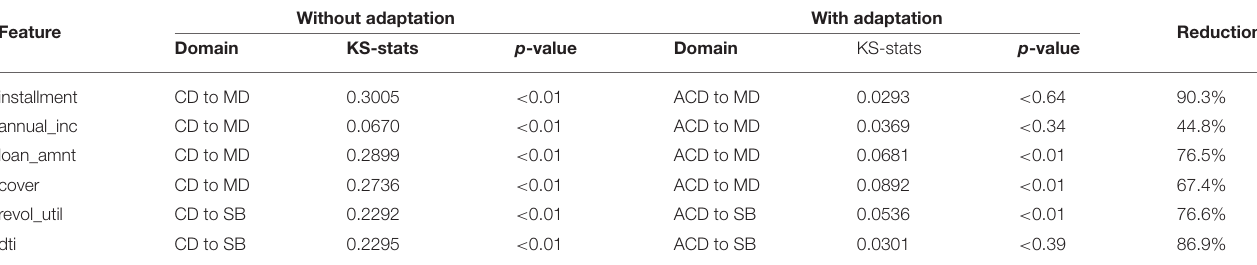
TABLE 8 | Kolmogorov-Smirnov test to compare source data and target data, before and after the source data is adapted, ACD is the abbreviation for Adapted Credit card and Debt consolidation data.